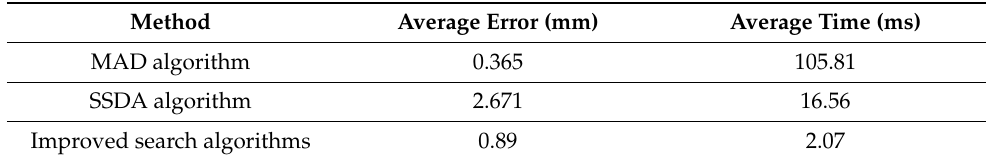
Table 7. Magnetic field matching